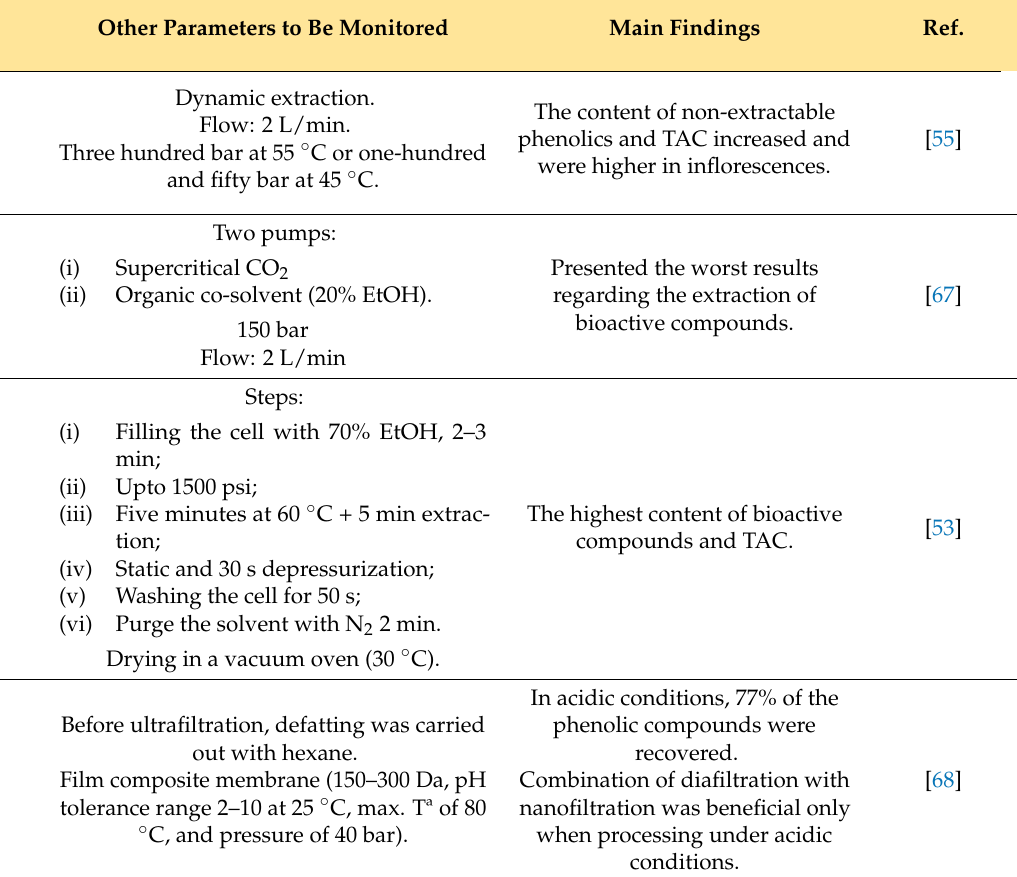
Table 4. Other green technologies used for the extraction of bioactive compounds from Brassica by-products. By-Product Characteristics Other Parameters to Be Monitored Main Findings Ref. Broccoli leaves, stems,